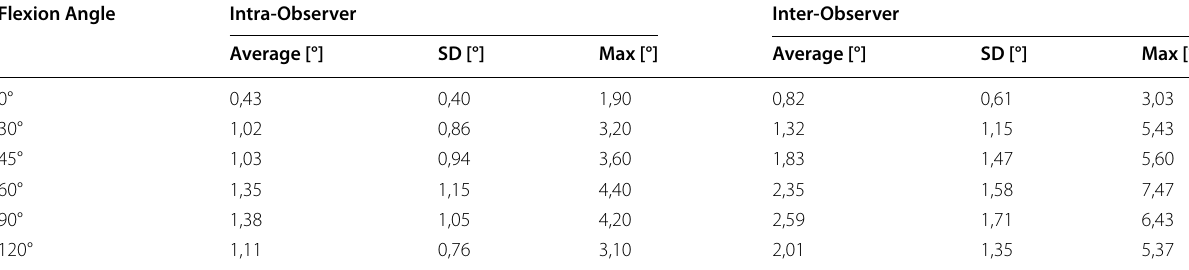
Table 4 Intra-observer and inter-observer variability for internal-external rotation measurements Flexion Angle Intra-Observer